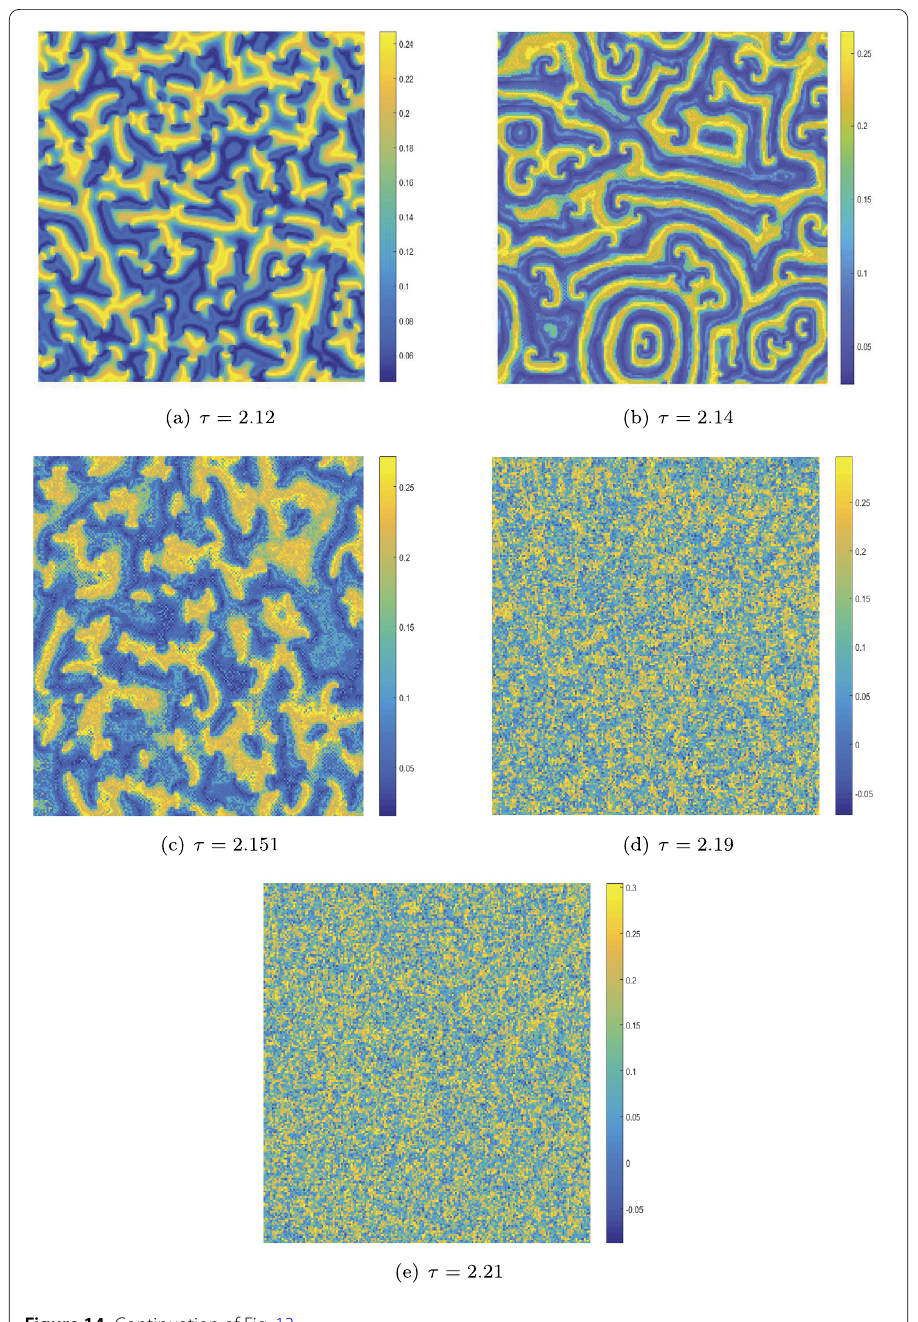
duced patterns have the characteristic of a spiral. In the transition of the spatial patterns, we observe that the change of τ value influences the sizes of spots in the patterns, please see Fig. 13(b)–(c). The patterns induced by chaos present disorder behavior both in time and space. We choose two different values of τ to see whether the patterns are the same. In fact, both patterns present irregular patterns. For larger τ , the patterns are more complex and